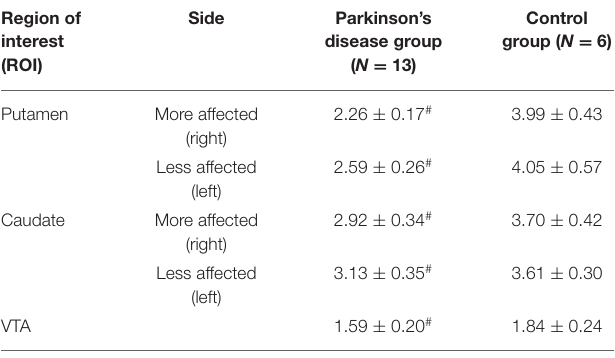
TABLE 2 | Levels of [ 11 C]CFT uptake ratio